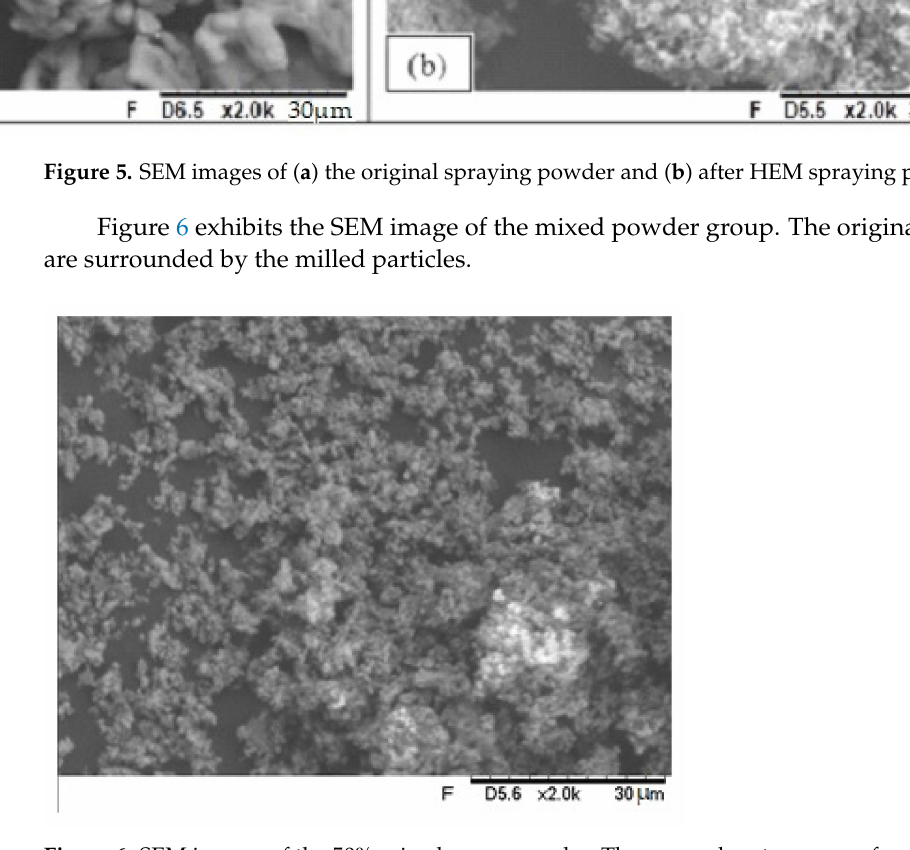
Figure 6. SEM images of the 50% mixed spray powder. The arrow denotes a gross fragment of the original particle surrounded by the milled particles. Figure 7 denotes the representative SEM metallographic images of the coating with powder (a) milled, (b) original, and (c) 50% mixed. The dense microstructures are typical of carbide coatings sprayed with high-velocity flaming [35]. The light gray phase is the NiCr matrix distributed between the carbide particles (dark gray phase). The darker areas were also observed, which are the characteristic pores of the coatings